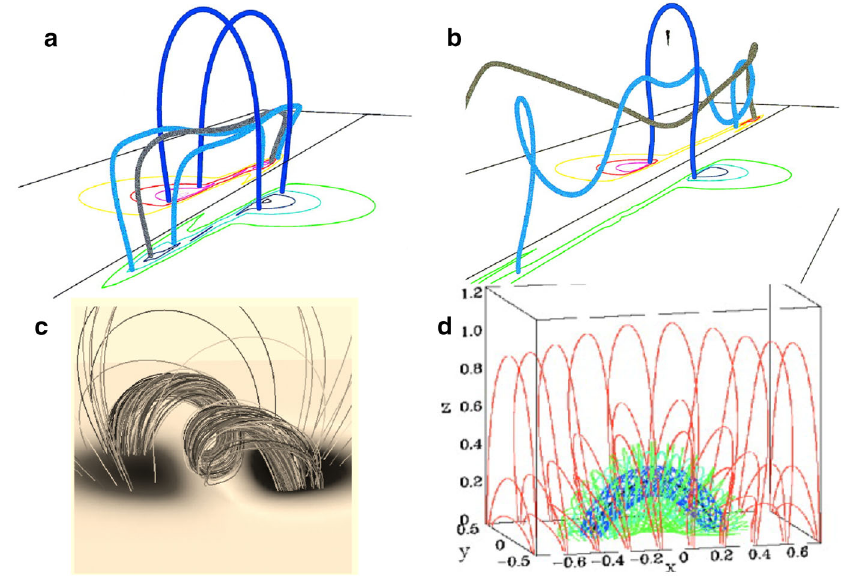
Fig. 5 3D magnetic configurations with dipped field capable of supporting prominences. Field lines from DeVore and Antiochos (2000) a sheared arcade and b flux rope; c Amari et al. (1999) and d Fan and Gibson (2004) flux ropes. Images reproduced with permission, copyright by